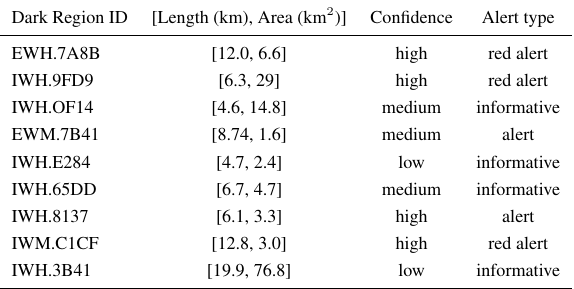
Table 3. Bilge dump confidence and alert system results